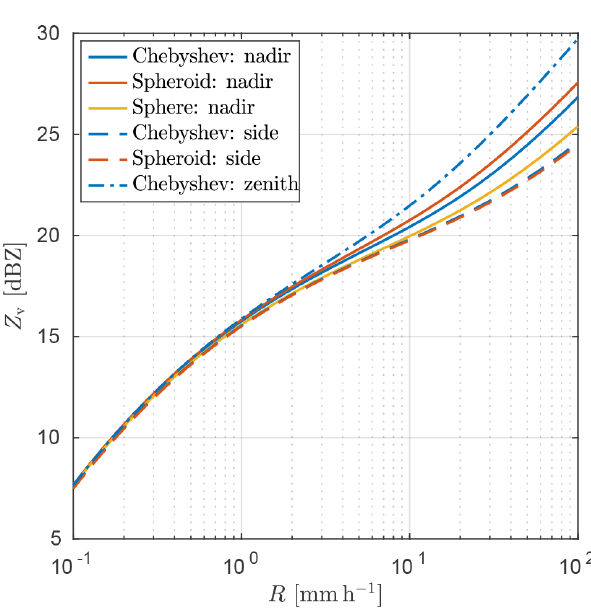
Figure 2. Vertically polarized radar reflectivity Z v , shown in units of dBZ, as a function of rainfall rate R at